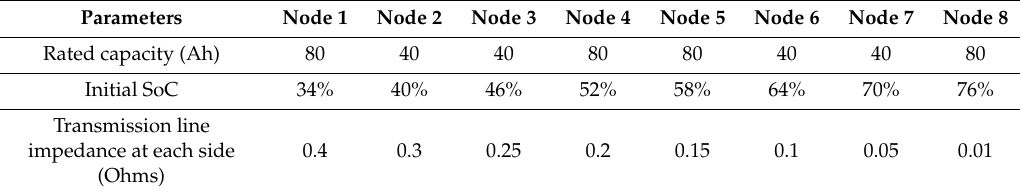
Table 2. Private parameters of 8